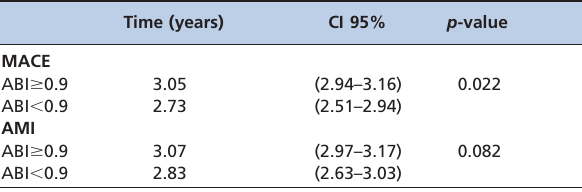
Table 3 - Time elapsed between the PAD diagnosis and the occurrence of major cardiovascular events (MACE) and acute myocardial infarction